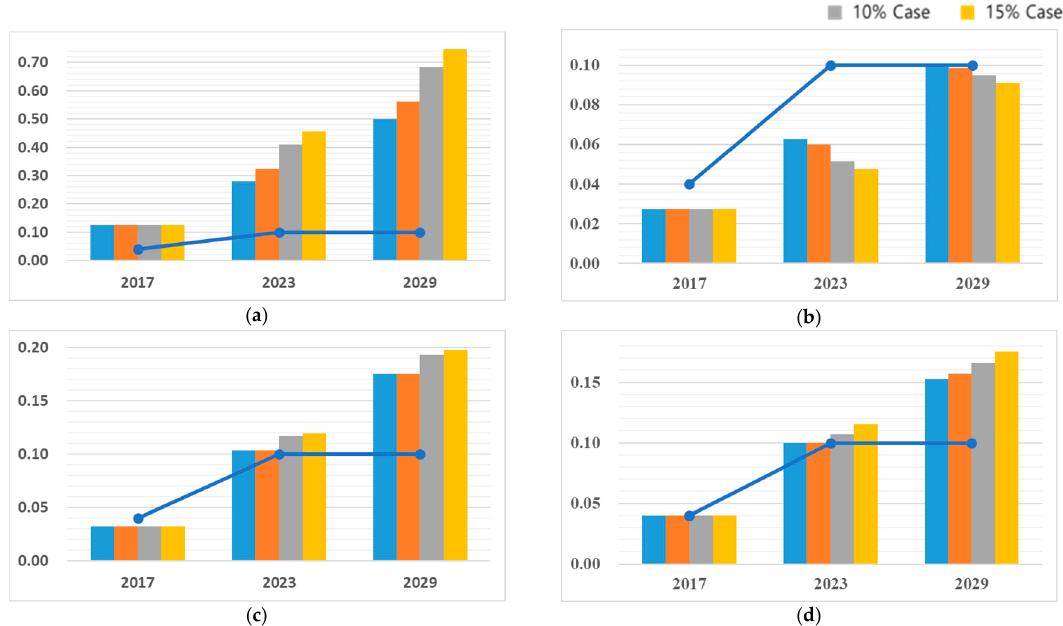
Figure 17. RPS ratio changes with CER price increases in: ( a ) AP segment (M10); ( b ) IL segment (M1); ( c ) IF segment (M18); ( d ) RS segment (M5).